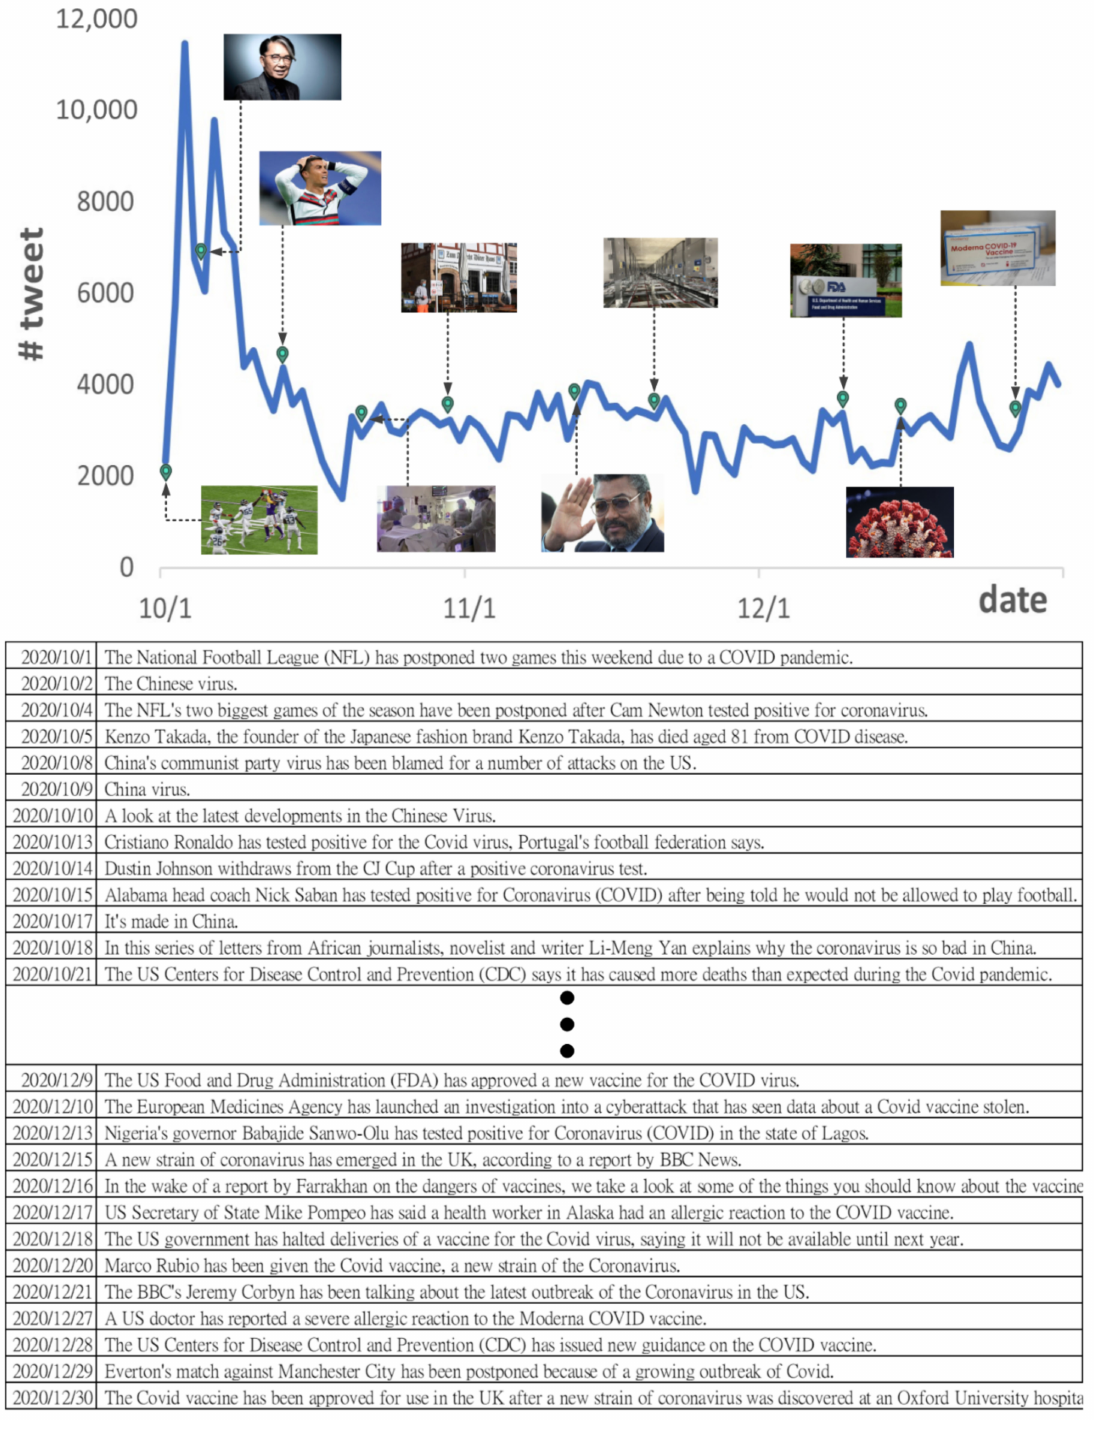
Figure A3. Generated storyline related to COVID-19 from October to December